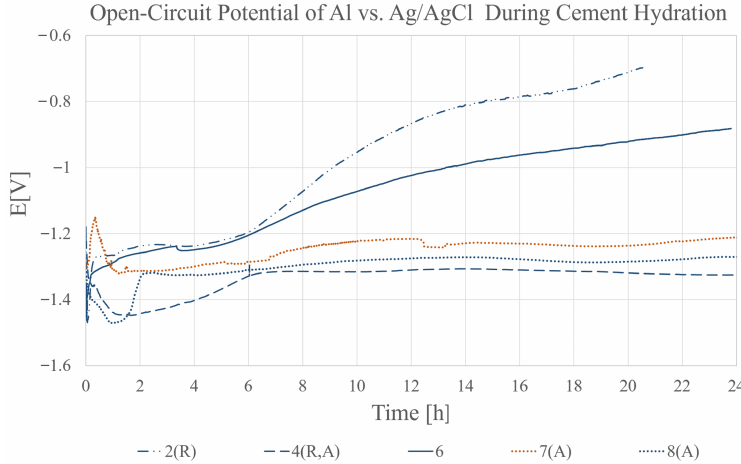
Figure 5. The OCP between an Ag/AgCl reference and counter electrode and the aluminum sample embedded in a cement paste with 51% calcined kaolinitic clay during the cement hydration. The blue curves represents samples form the right arm and the orange curve sample from the left arm of the lattice. The line style differentiates between the sample